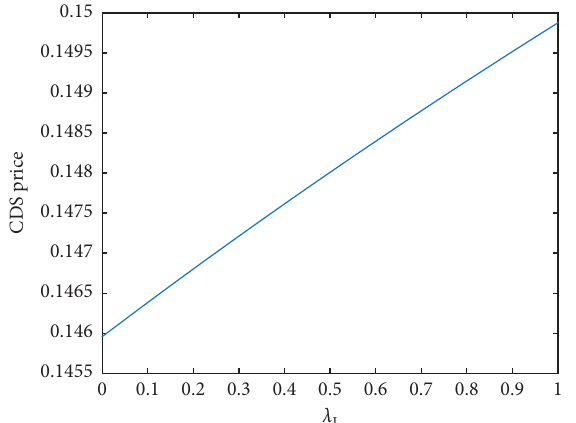
Figure 10: The price differences of basket CDS with two defaultable � 0 . 01. J if ε i counterparties and that with only one defaultable